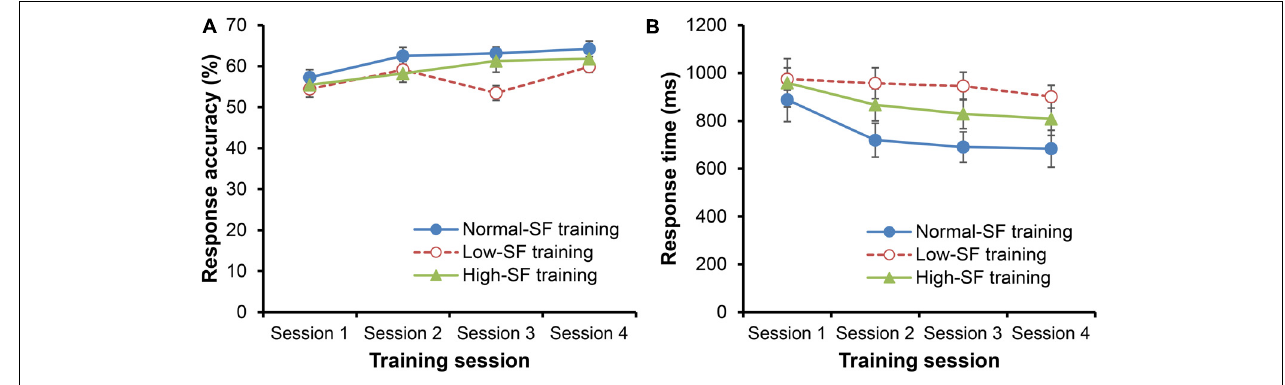
FIGURE 4 | Mean response accuracy (A) and response time (B) during training intervention. Error bars indicate the standard error of the mean.